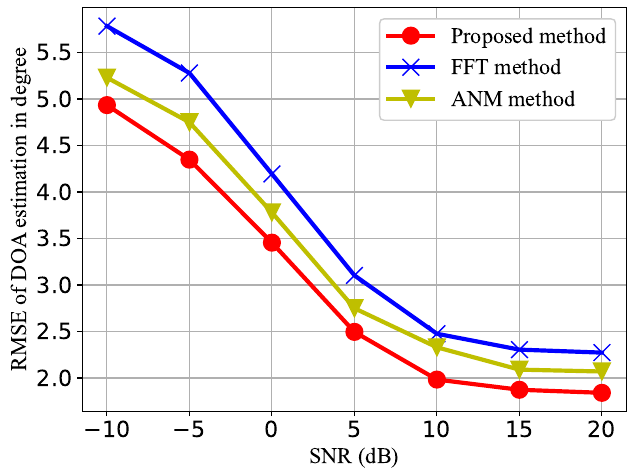
Figure 17. The RMSE of the DOA estimation using 1-bit ADC to show the performance of the proposed